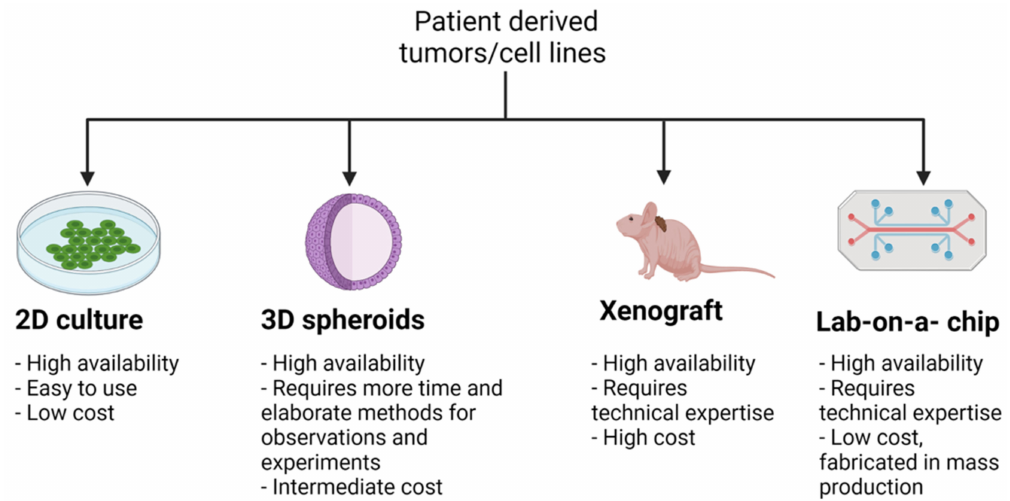
Figure 2. Summary of patient derived tumor models and cell lines. Various models of cancer are in use, each with their own applications, advantages, and disadvantages. 2D cultures are a widely used model for understanding cell biology and tissue morphology, as well as mechanisms of disease progression and actions of drugs [31]. Their high availability, ease of use, and low cost allow for high throughput data collection, although data from 2D cell lines alone is usually insufficient without further studies that more closely mimic in vivo conditions. 3D models, such as organoids and spheroids,